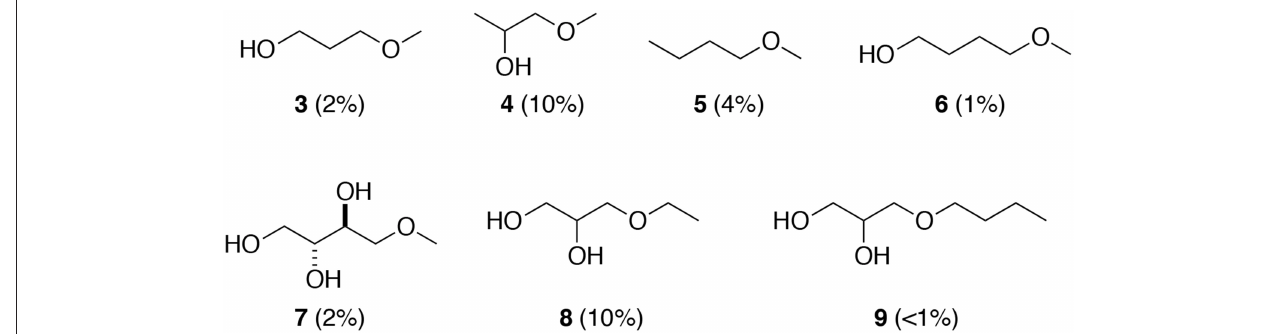
FIGURE 2 | Applications of the O -alkylation in subcritical alcohol.